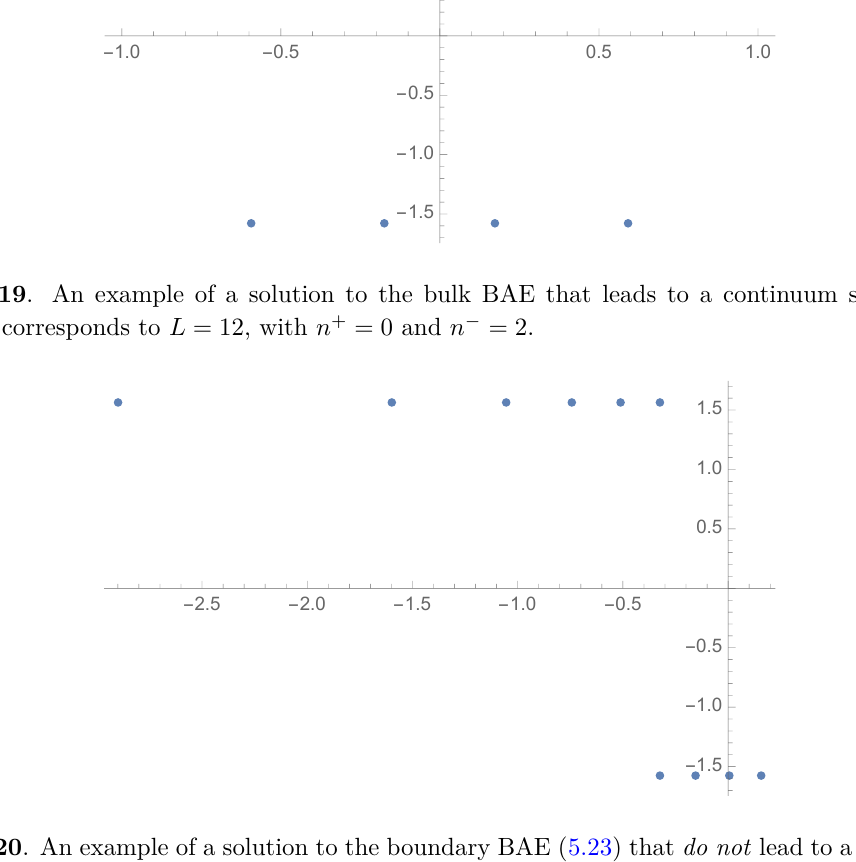
Figure 20 . An example of a solution to the boundary BAE (5.23) that do not lead to a continuous spectrum, unlike the bulk case. This example corresponds to L = 12 , with n + = 0 and n − = 2